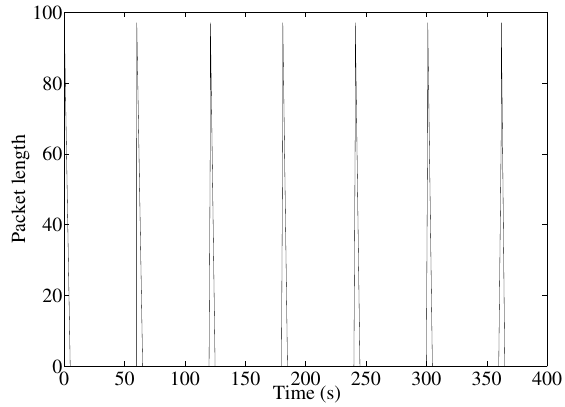
Figure 3. When idle, only heartbeat traffic is visible. This is one packet from client to server and one in the opposite direction, with the respective answers.